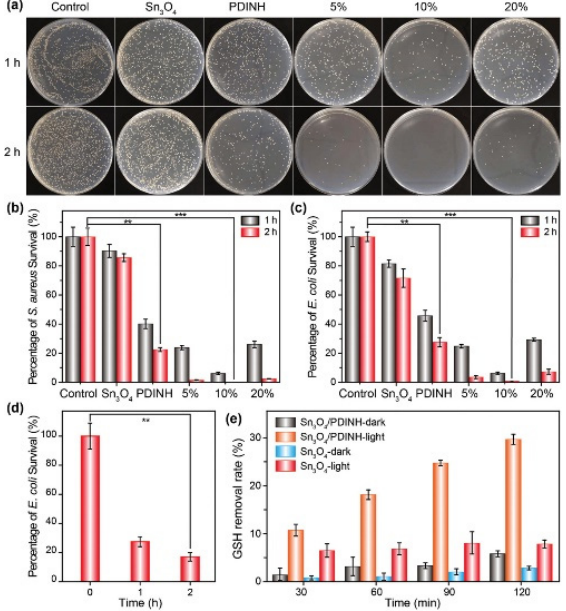
Figure 16. Antibacterial activity. ( a ) Photographs of antibacterial results under simulated sunlight illumination ( S. aureus ). Antibacterial activities of the different materials under simulated sunlight illumination: ( b ) S. aureus and ( c ) E. coli . ( d ) Antibacterial performance of Sn 3 O 4 /PDINH heterostructure under NIR irradiation ( λ > 700 nm). ( e ) GSH losing histograms after incubation with materials under simulated sunlight illumination or not. [180]. Shen et al. synthesized novel three-dimensional Bi 2 S 3 nanocrystals capped by polyvinyl pyrrolidone photocatalyst for the reduction of hexavalent chromium under visible light irradiation. TEM images display flower-like structures consisting of nanosheets (Figure 17). The reduction of metals with such an impressive photocatalyst reaches 95% in only 5 min of reaction (Figure